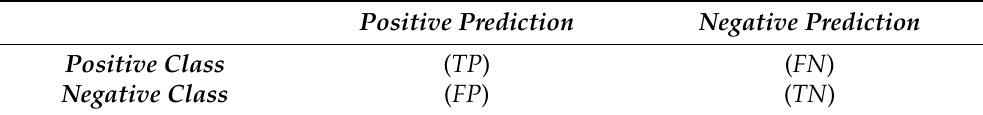
Table 1. Example of confusion matrix structure for binary